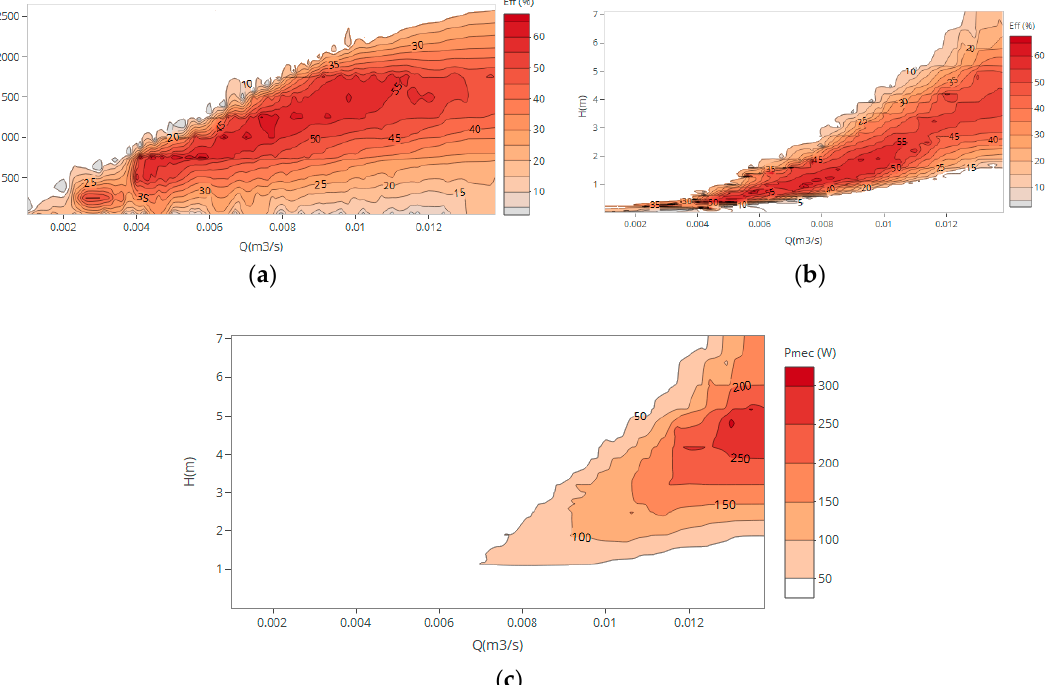
Figure 5. Hill charts obtained from numerical simulations: ( a ) Efficiency vs. flow and rotational speed; ( b ) Efficiency vs. flow and head; ( c ) Mechanical power vs. flow and head.